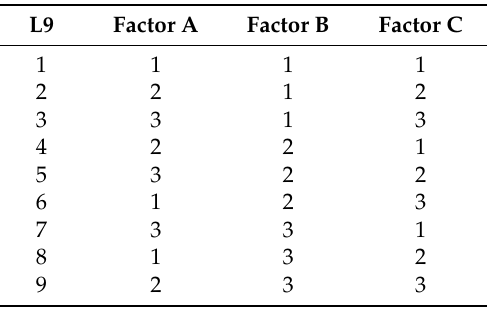
Table 3. Orthogonal table of L9 (3 3